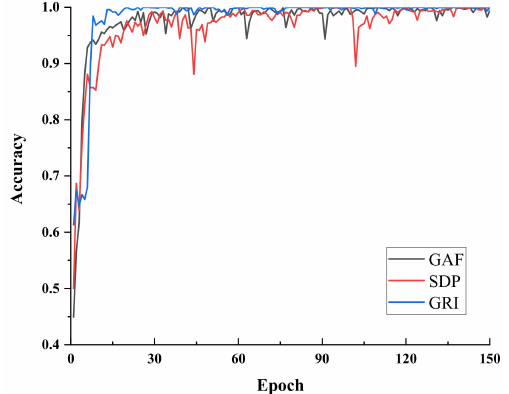
Figure 2. Accuracy change curve of model training set.